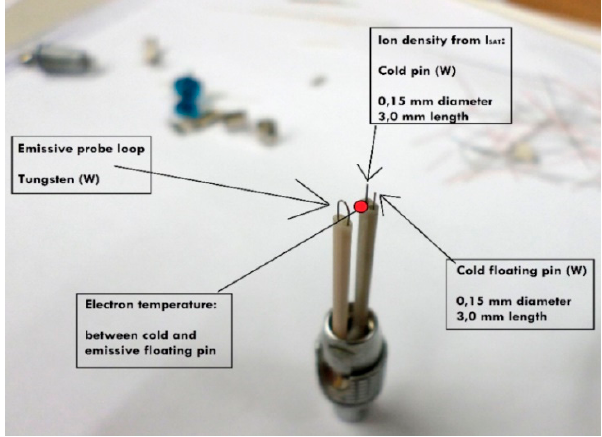
Figure 2. Probe assembly for measurements in a high-power impulse magnetron sputtering discharge (HiPIMS) in Cu, made of W-wire and Al 2 O 3 tubes, consisting of an electron-emissive probe (EEP), a floating cold Langmuir probe (CLP) and a negatively-biased CLP [16].